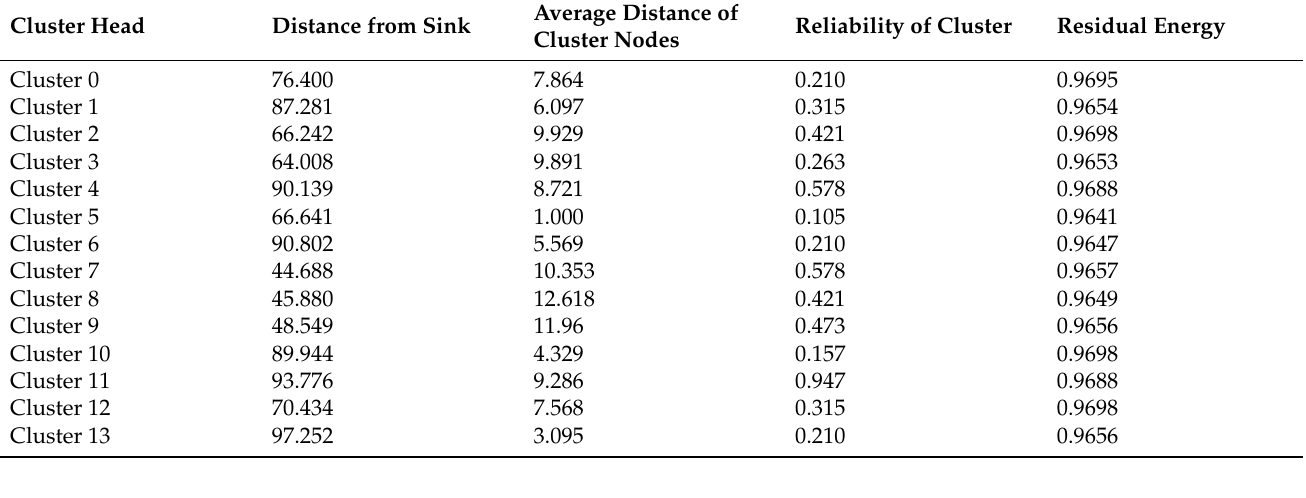
Table 5. The 14 cluster heads along with their all-parametric values.